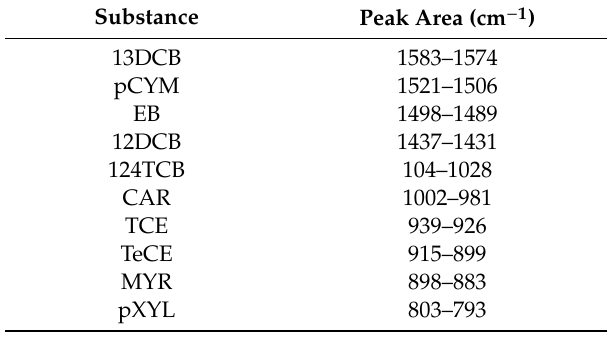
Table 1. Integration limits used for the univariate data evaluation (i.e., peak area